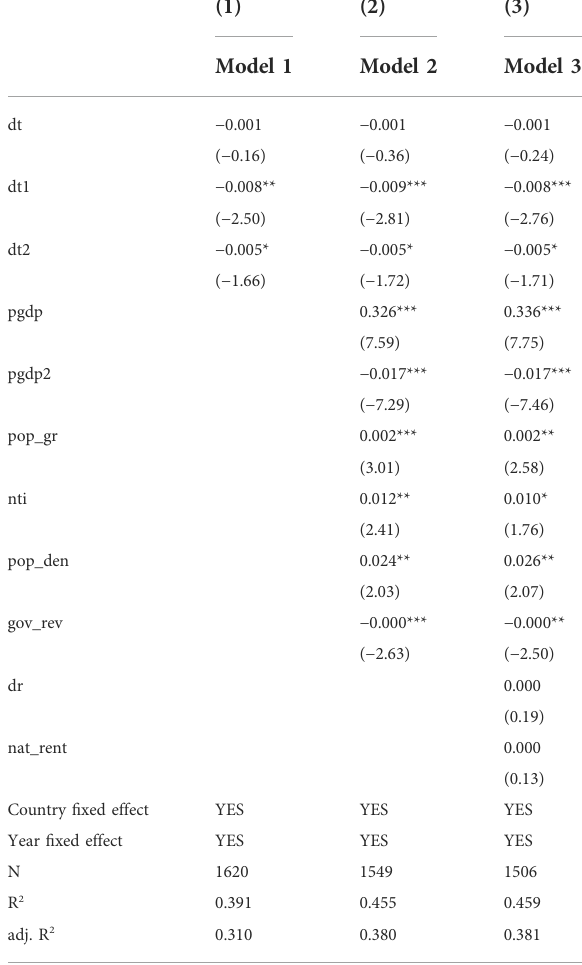
TABLE 9 Effects of the Belt and Road Initiative on environmental quality: Heterogeneous time